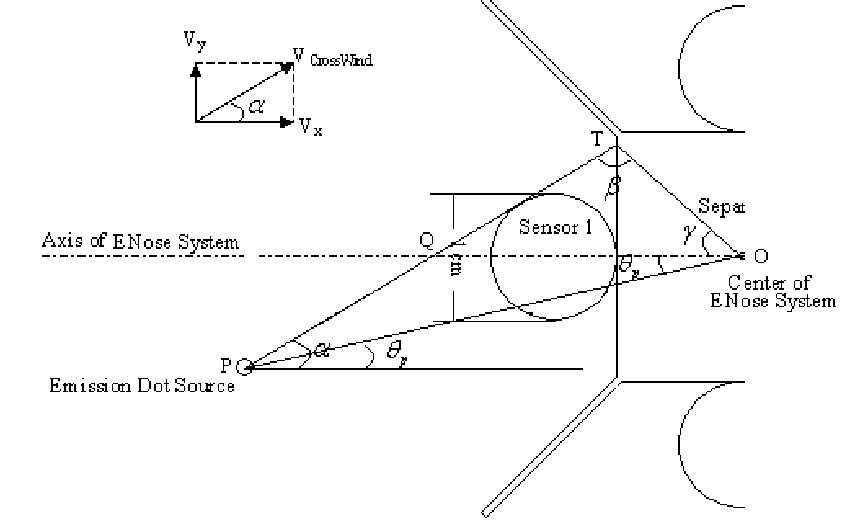
Figure 4 . Simulated series of stable sensors responses in crosswind case according to different source direction